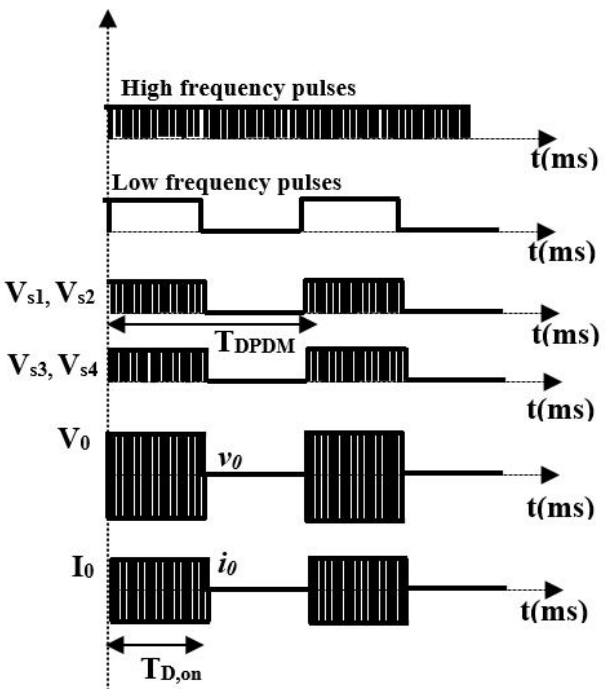
Figure 13. PDM pulse generation.